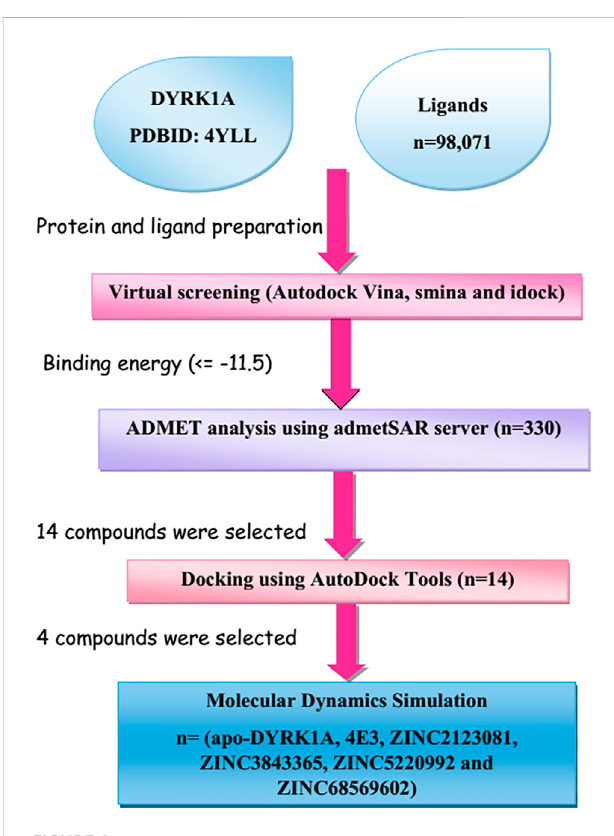
FIGURE 1 Representation of the brief methodology used in the present study to screen the library of 98,071 ligands against DYRK1A using the high- throughput virtual screening approach, followed by MD simulations of the four best lead compounds on 100